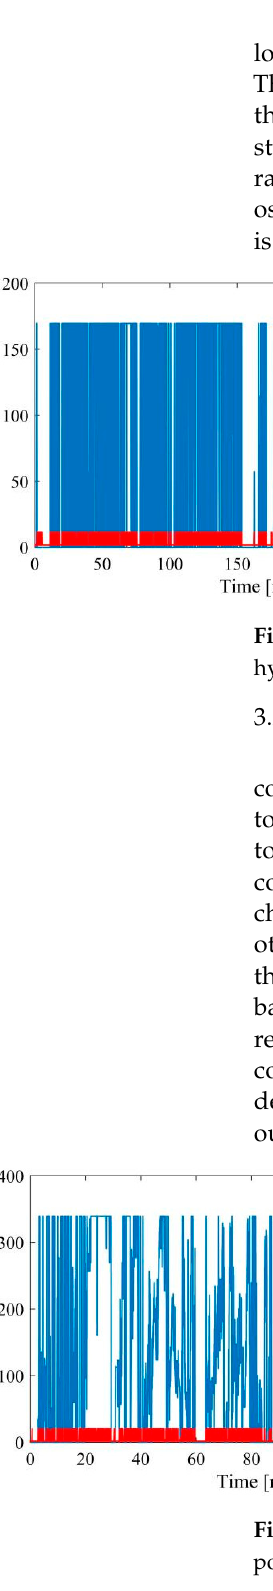
16 of 22 Figure 10. AMV performance in Journey 2: ( a ) Motor mechanical power trends; ( b ) Fuel cell power, hydrogen tank and battery state of charge trends. 3.2.3. Journey 3